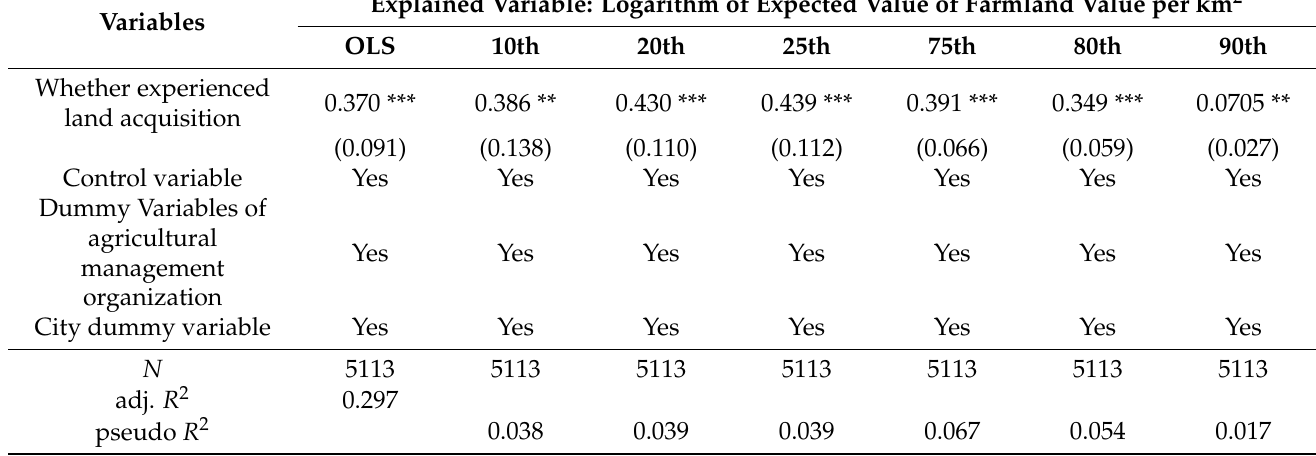
Table 6. The impact of land acquisition experience on farmers’ farmland value expectation: quantile regression. Explained Variable: Logarithm of Expected Value of Farmland Value per km 2 Variables OLS 10th